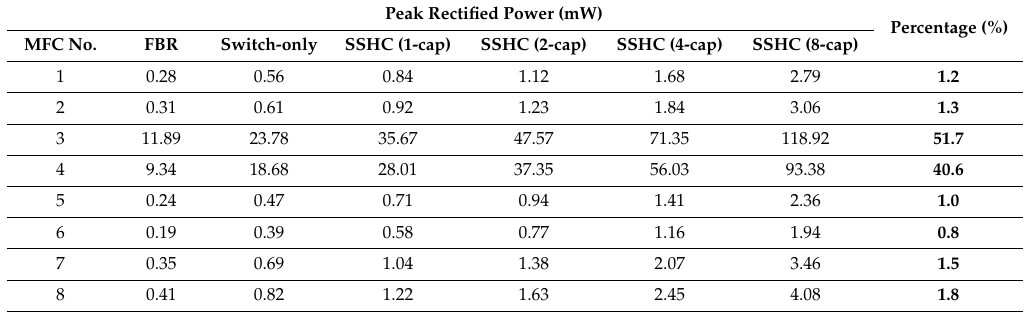
Table 6. Peak output power from individual MFC elements and their contributions to the total